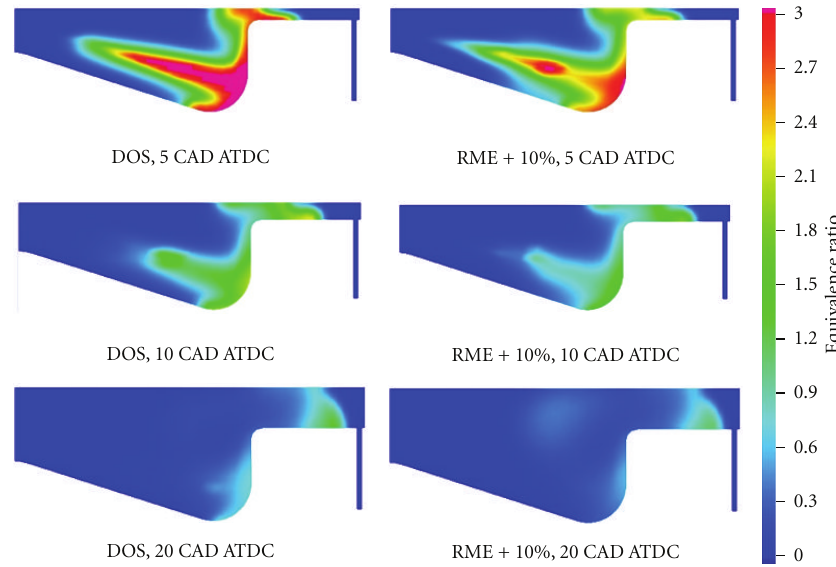
Figure 13: In-cylinder equivalence ratio distribution for the Volvo D12C Diesel engine fuelled by DOS and RME+ 10% at 5, 10, 20 CAD ATDC without